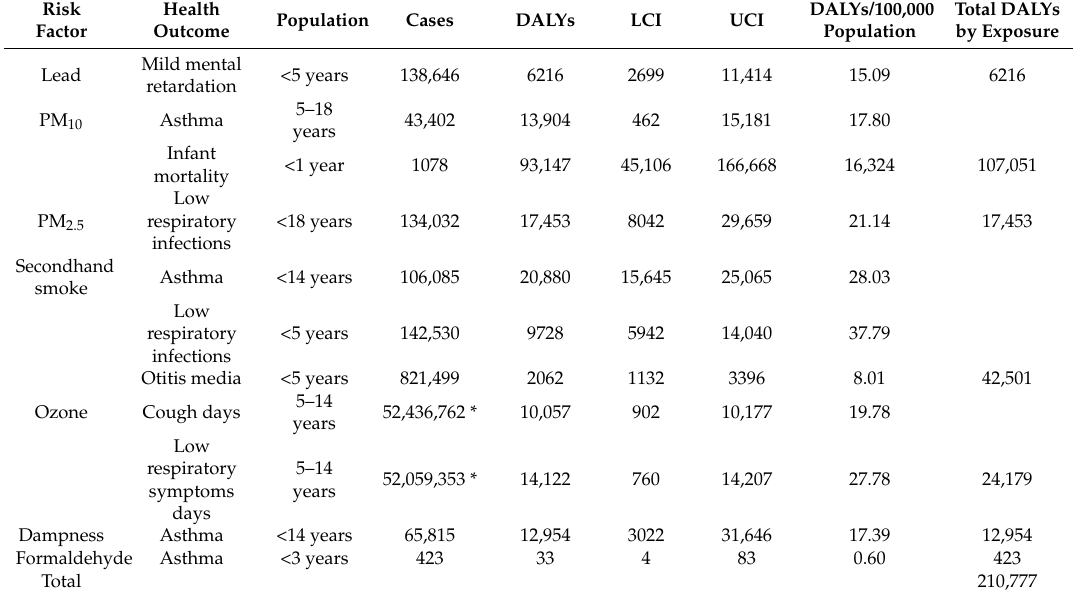
Table 2. Environmental burden of disease in EU28, in the population less than 18 years old. Risk Health Population Cases DALYs LCI UCI Factor Outcome